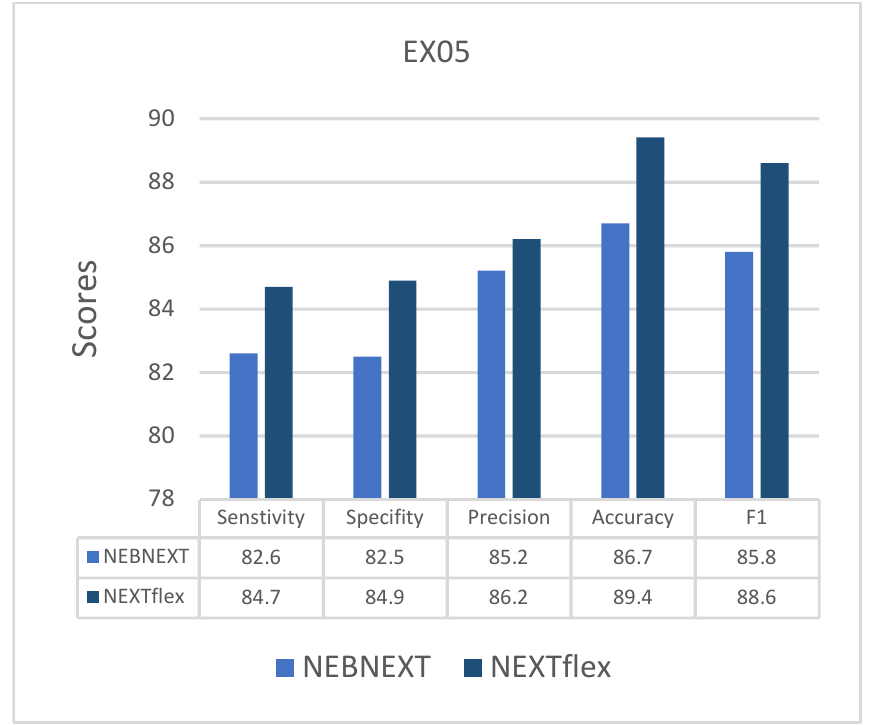
Figure 13. Accuracy scores of biomarker detection of: (a) Applying Model_0 on the samples of Da- taset_I prepared by NEBNEXT library (21 samples). (b) Applying Model_0 on the samples of Da- taset_I prepared by NEXTflex (21 samples).